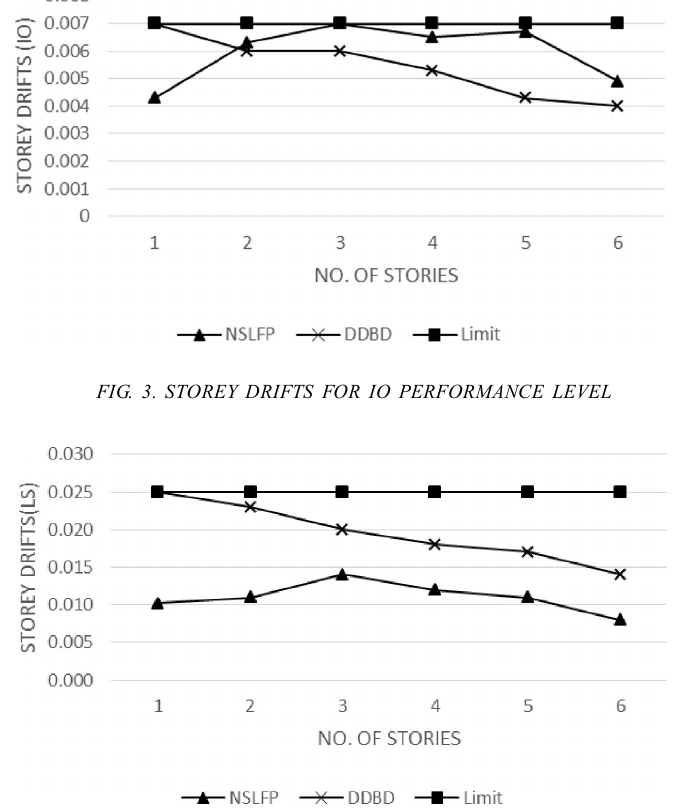
FIG. 4. STOREY DRIFT FOR LS PERFORMANCE LEVEL